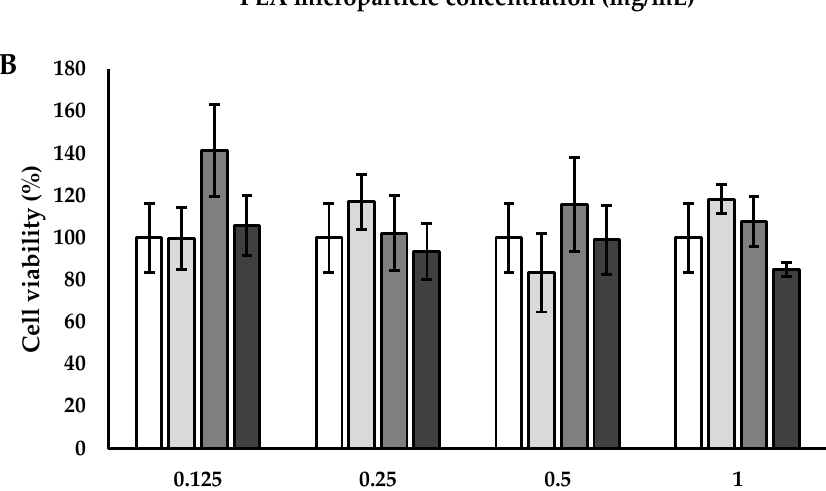
Figure 10. Cell viability of endothelial cells grown for ( A ) 24, ( B ) 48, and ( C ) 72 h in the presence of PLA MPs, * p < 0.05 (with respect to the control using ANOVA with Tukey ’ s HSD post hoc multiple comparison test). PLA: poly(lactic acid).